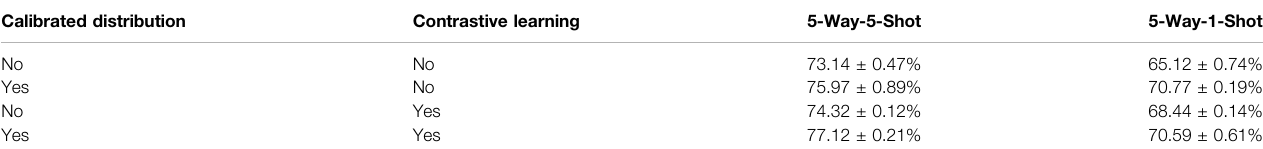
TABLE 4 | Ablation study on 5-way-5-shot and 5-way-1-shot classi fi cation tasks with SHREC19. Calibrated distribution